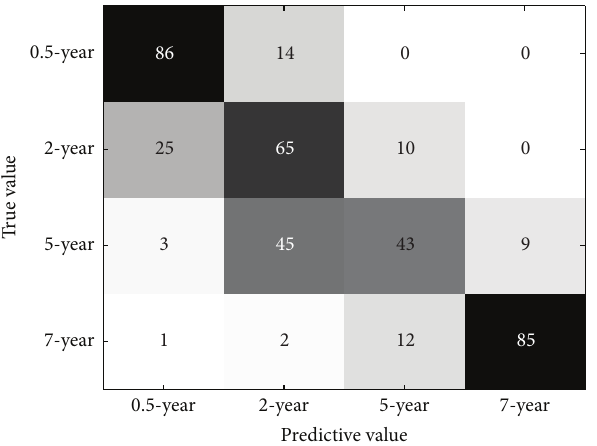
Figure 10: Optimized DFNN confusion matrix for testing